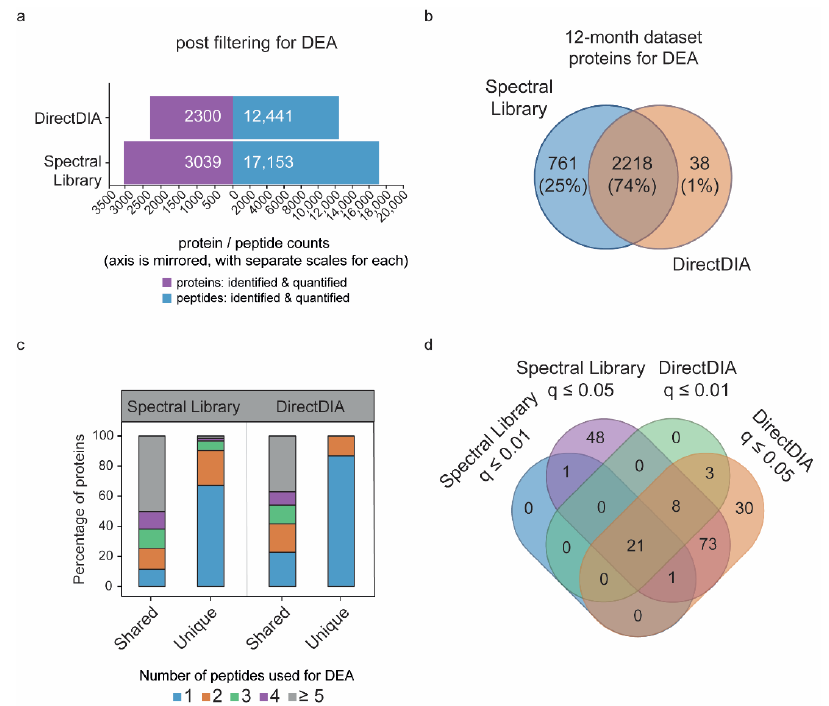
Figure 2. Characterization of proteins used for differential expression analysis in MS-DAP obtained by a DDA-based spectral library or directDIA. ( a ) Number of proteins and peptides that remain after filtering for differential expression analysis. ( b ) Number of unique and shared proteins used for downstream analysis identified by the DDA-based spectral library or directDIA. ( c ) The percentage of shared or uniquely identified proteins, using the spectral library or directDIA, that is represented by the specified number of peptides. ( d ) The number of regulated proteins identified using the different library searches and the specified empirical Bayes cut-offs for statistical